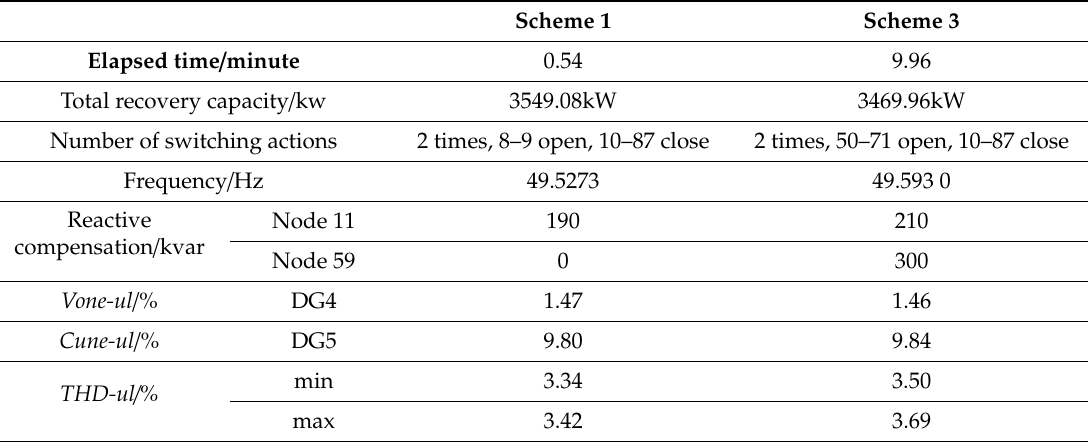
Table 4. Results of the two-step optimization model and the single-layer optimization model for benchmark